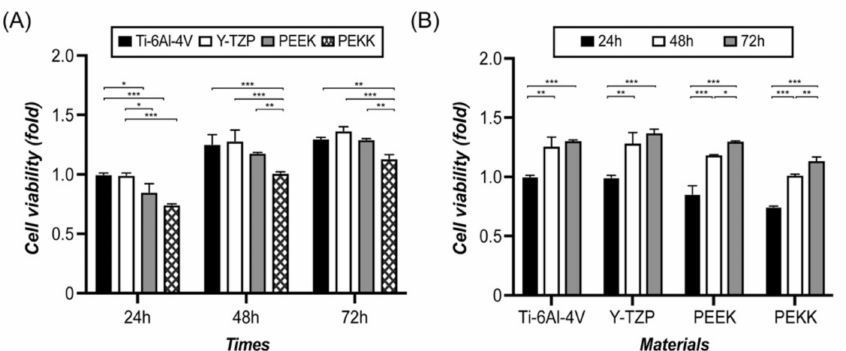
Figure 2. Cell metabolic activity of HOF in direct contact with the surface of the abutment material (Ti-6Al-4V, Y-TZP, PEEK, or PEKK) for 24 h, 48 h, and 72 h, assessed through MTT assay. Significant difference is based on a one-way ANOVA with Tukey’s multiple comparisons test to compare ( A ) the differences in effect between the materials and ( B ) the effect within the same material over specific time periods. (* p < 0.05, ** p < 0.01, *** p <